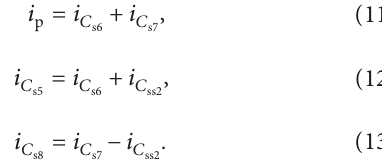
7 is turned off before